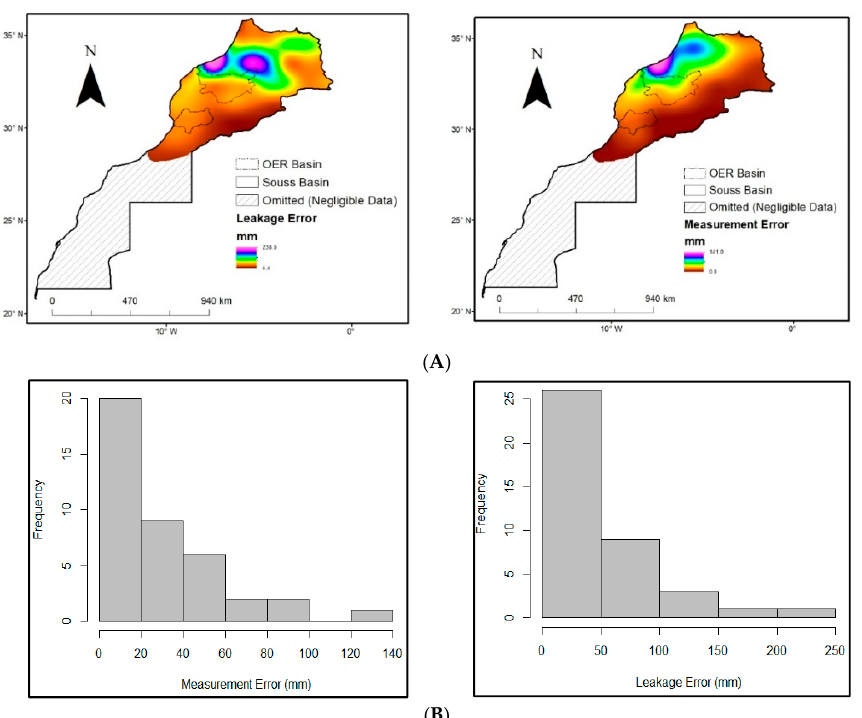
Figure 3. ( A ) Measurement and leakage errors for GRACE; ( B ) Histogram error distribution for measurement and leakage errors within Morocco.